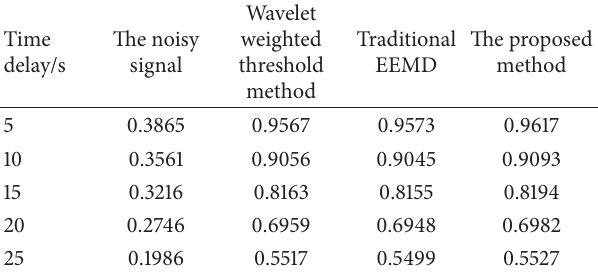
Table 3: Autocorrelation of vibration signals.